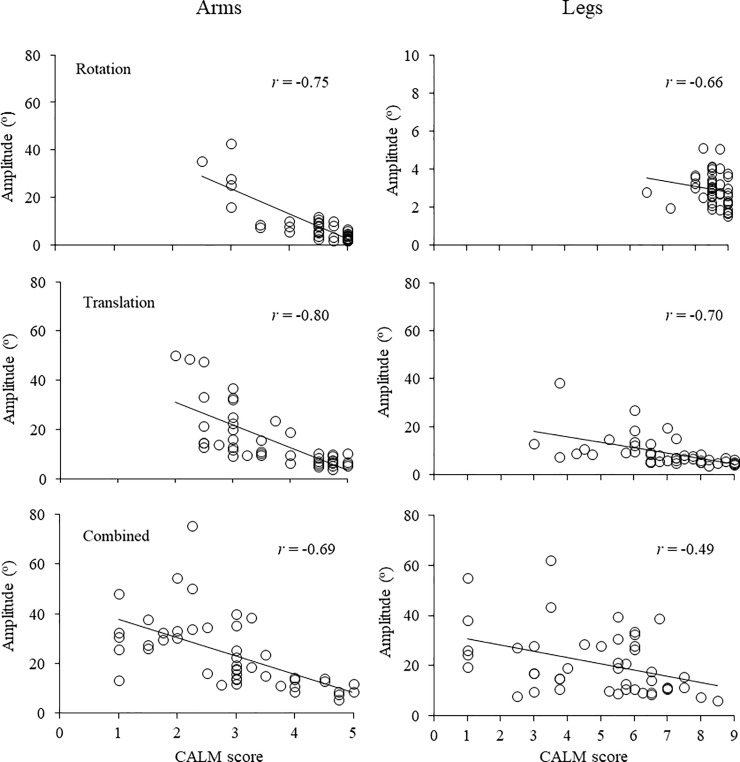
Correlation of CALM scale score and movement amplitude.Scatter plots and rs values for correlations between CALM scale scores and respective movement amplitude based on kinematics for arm (left column) and leg (right column) movements, representing high velocity perturbations in the rotation (upper panels), translation (intermediate panels) and combined (lower panels) modes of perturbation. Data were collapsed between the groups and perturbation sides.